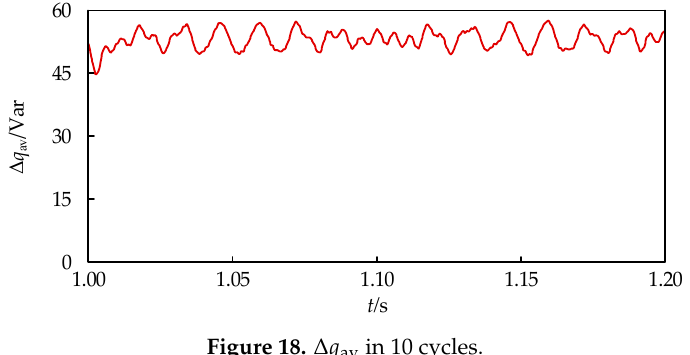
Figure 18. ∆ q av in 10